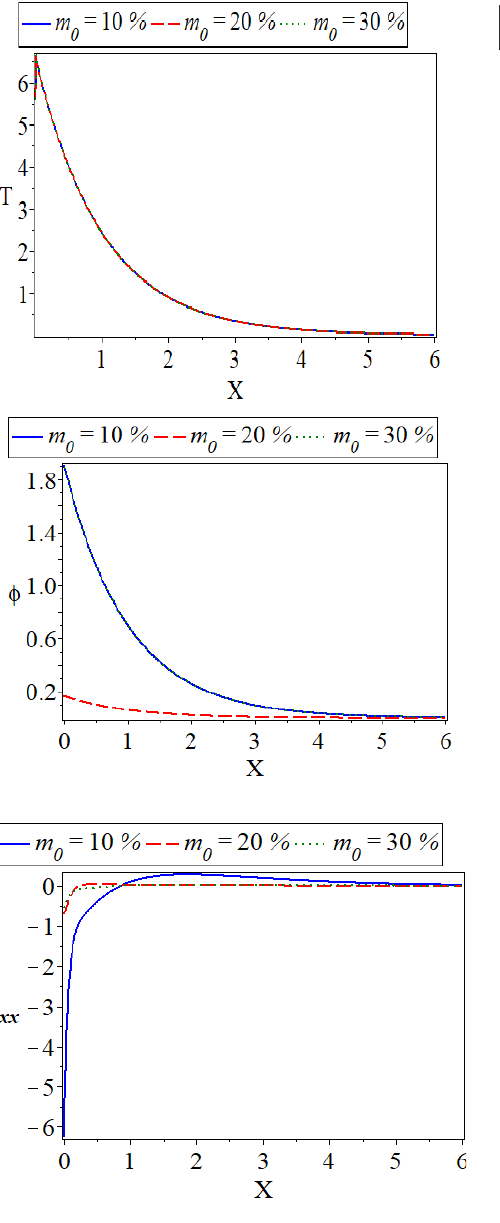
Figure 3. The variation of physical field distributions with distance at different values of thermo- elastic coupling parameter 1  under the effect of moisture field and Figure 1. Represents the variations of main fields in this phenomenon according to the different values of two-temperature parameter under the effect of moisture field. values of two-temperature parameter under the effect of moisture field.